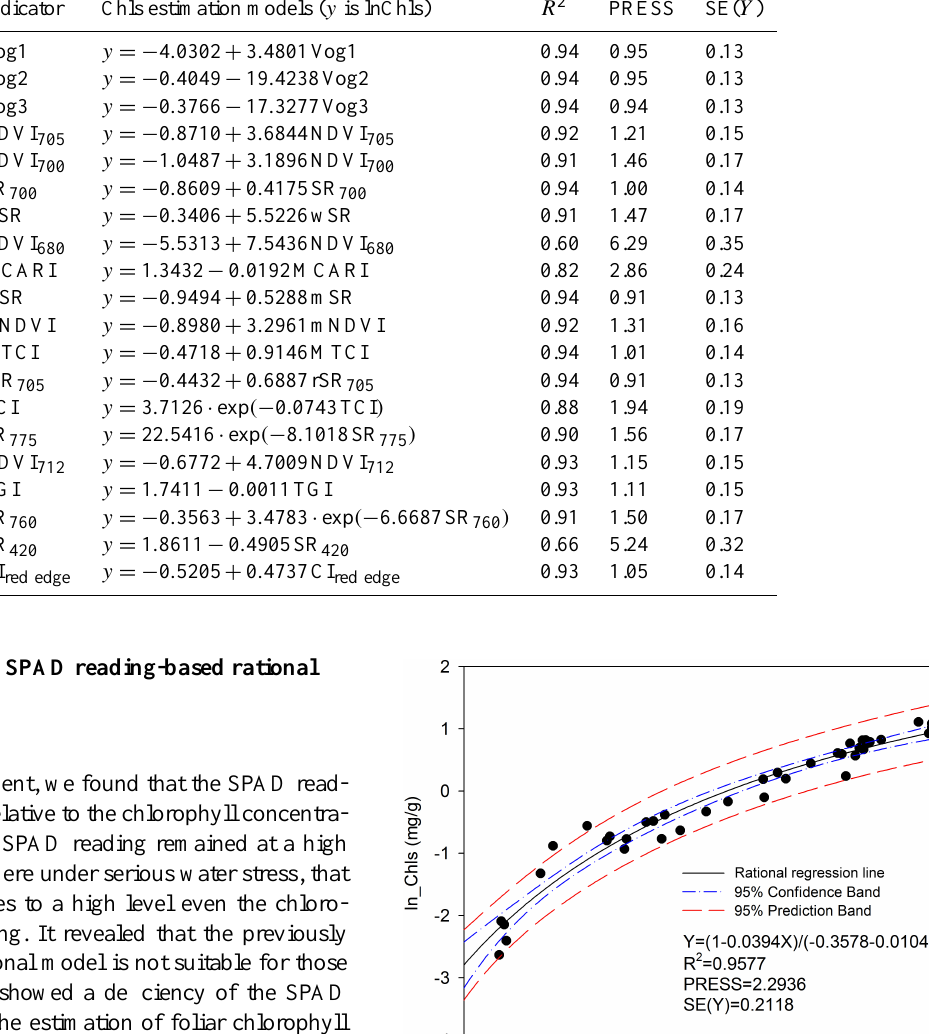
Table 4. Narrow-band-based spectral indices developed as chlorophyll indicators. Indicator Chls estimation models ( y is lnChls) R 2